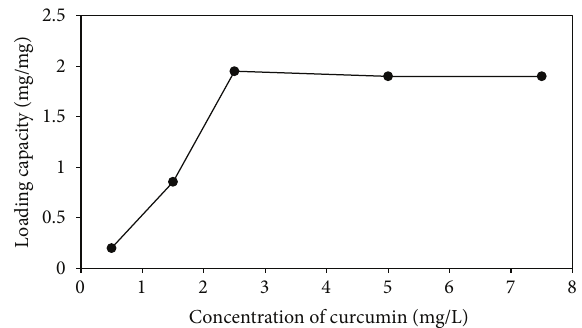
Figure 8: Effect of curcumin concentration on loading capacity of curcumin onto starch nanoparticles.